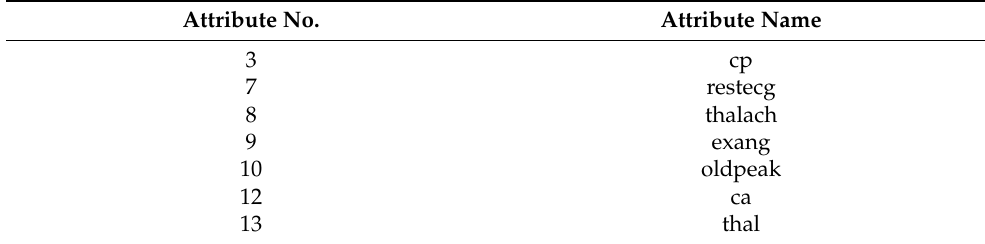
Table 3. Attribute sets that were obtained from the correlation-based feature selection. Attribute No.